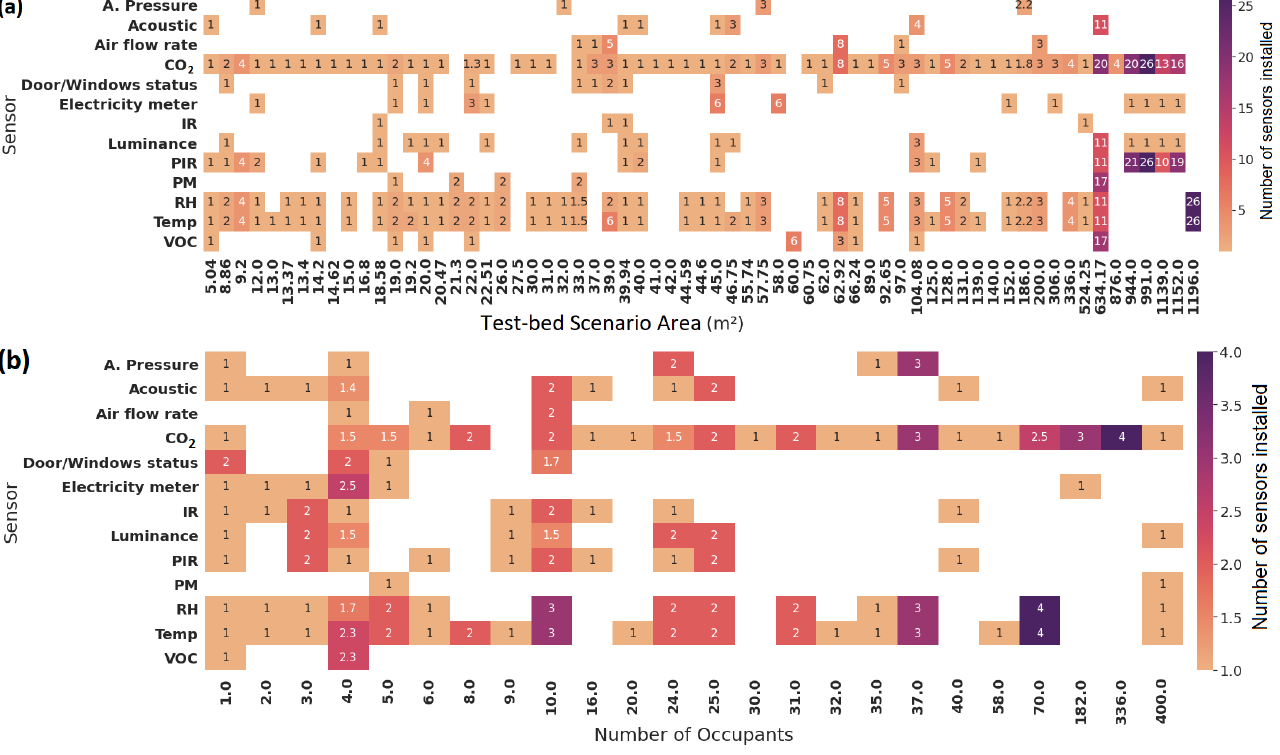
Figure 14. Type and total of sensors deployed. ( a ) Sensors installed by area. ( b ) Distribution of sensors installed by